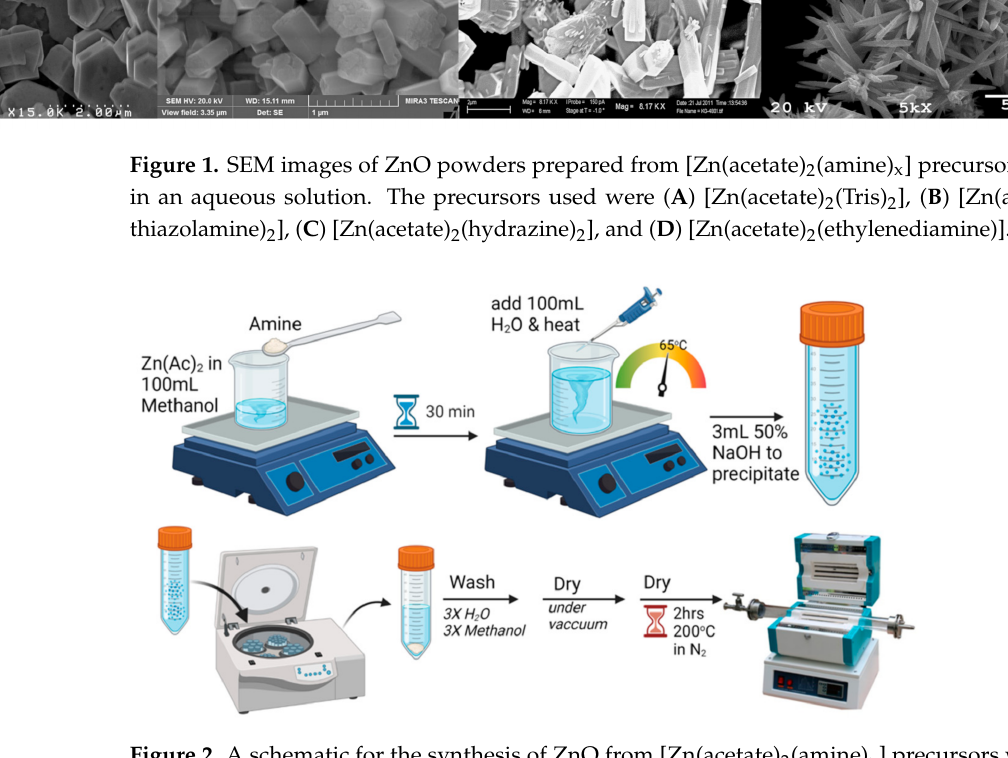
Figure 2. A schematic for the synthesis of ZnO from [Zn(acetate) 2 (amine) x ] precursors with rapid addition of NaOH to precipitate the product. This figure was created with